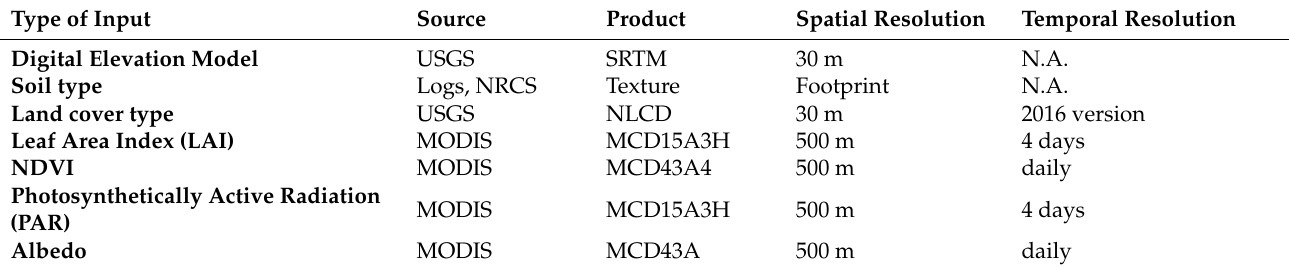
Figure 3. Model simulation coverage including each site flux footprint at ( a ) ARM-CF, ( b ) MOISST, ( c ) ARM-A74, and ( d ) ARM-A32. Flux footprints were computed using the method proposed by Kljun et al. (2015). Each red contour line represents a 10% inward increment, starting with 10% from the outermost contour line. Table 2. Topography, soil, and vegetation data sources with spatiotemporal